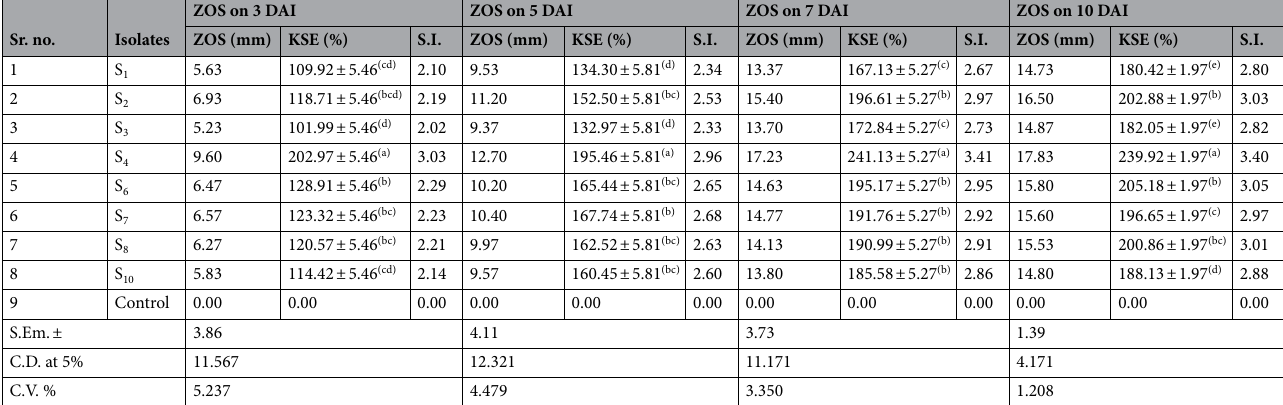
Table 9. Potash Solubilization Efficiency (KSE) of isolates on Aleksandrow’s media during 3, 5, 7 and 10 DAI. KSE Potash Solubilization Efficiency, ZOS Zone of Solubilization, S.I. Solubilization Index. Values of KSE (%) are mean ± standard error of 3 replicates. Different letters at various points indicate significant difference between treatments using Duncan’s multiple range test (P ≤ 0.01).